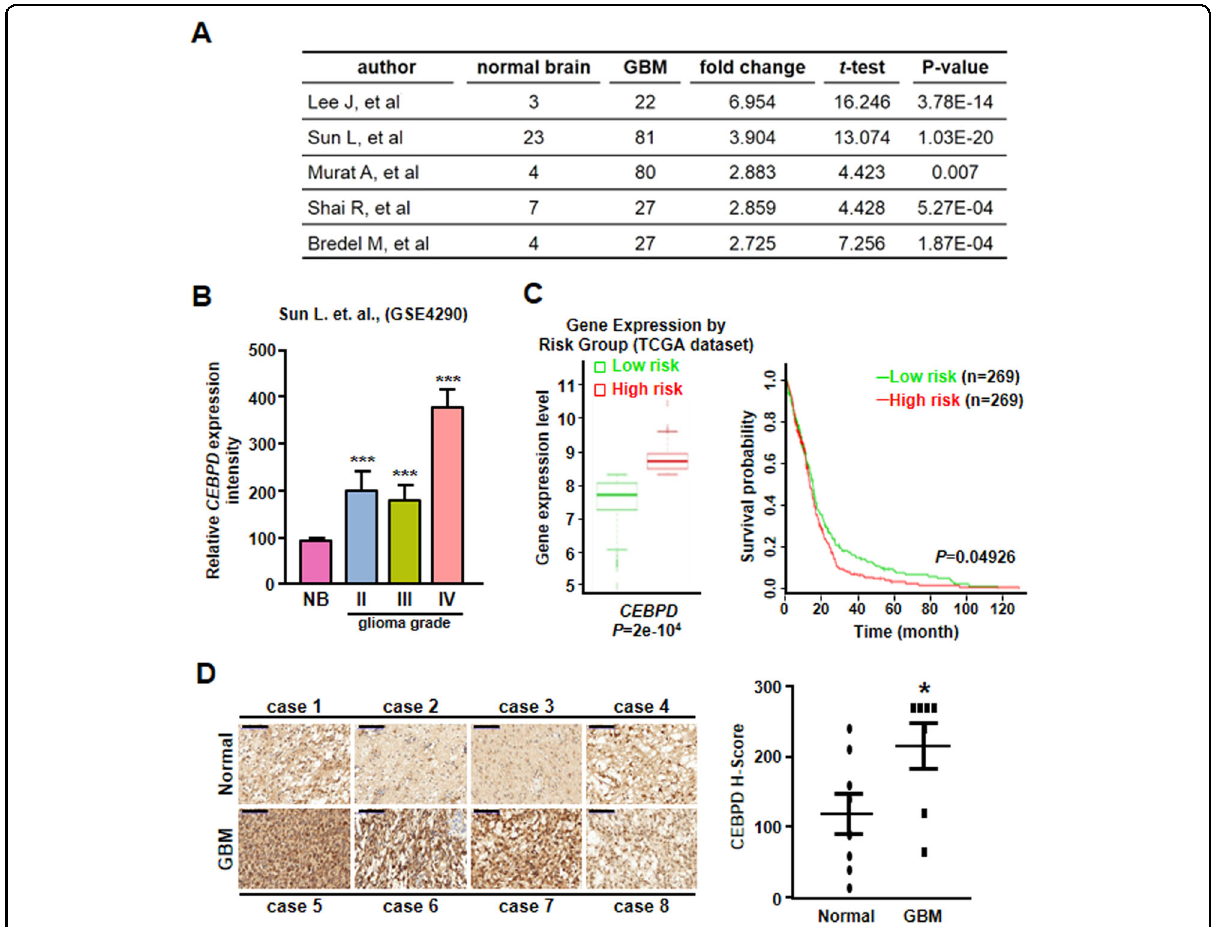
Fig. 1 Relative CEBPD expression is higher in GBM and is associated with a poor survival rate. A GEO database analyses showing higher CEBPD expression in GBM tissues than in normal brain tissues. B CEBPD expression is higher in various grades of human glioma tissues. C Analysis of Kaplan – Meier survival curves of high-risk GBM patients and low-risk GBM patients from TCGA. D Representative immunohistochemistry staining of CEBPD in GBM and normal brain tissues. The CEBPD H-score value is higher in GBM samples than in normal samples. Scale bar, 100 μ m. The summary data are presented as the mean ± SEM; the numbers in the bars represent the sample sizes; one-way ANOVA and Student ’ s t -test; * p < 0.05, *** p <